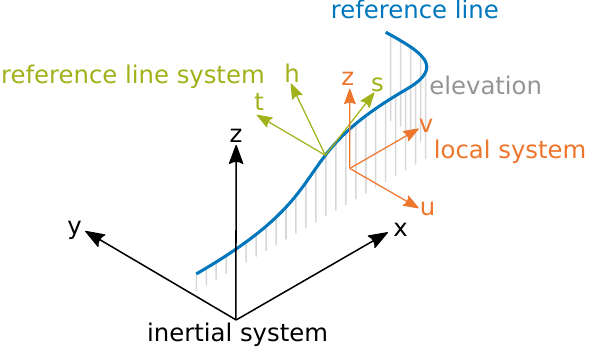
Figure 2. Three main coordinate systems used in OpenDRIVE.